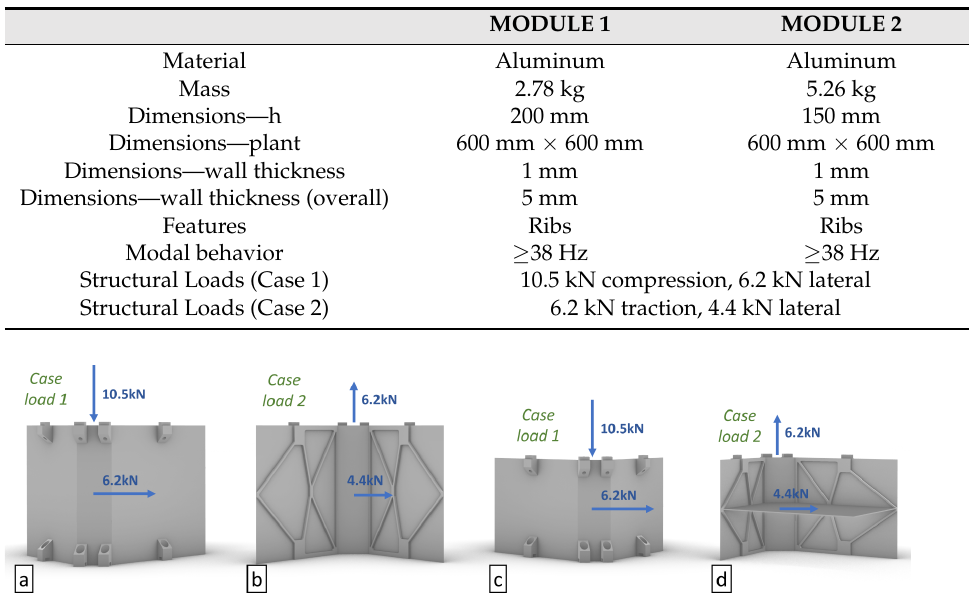
Figure 3. Sketch of module 1 ( a , b ) and module 2 ( c , d ) with the indication of the structural load for case 1 ( a , c ) and case 2 ( b , d ).